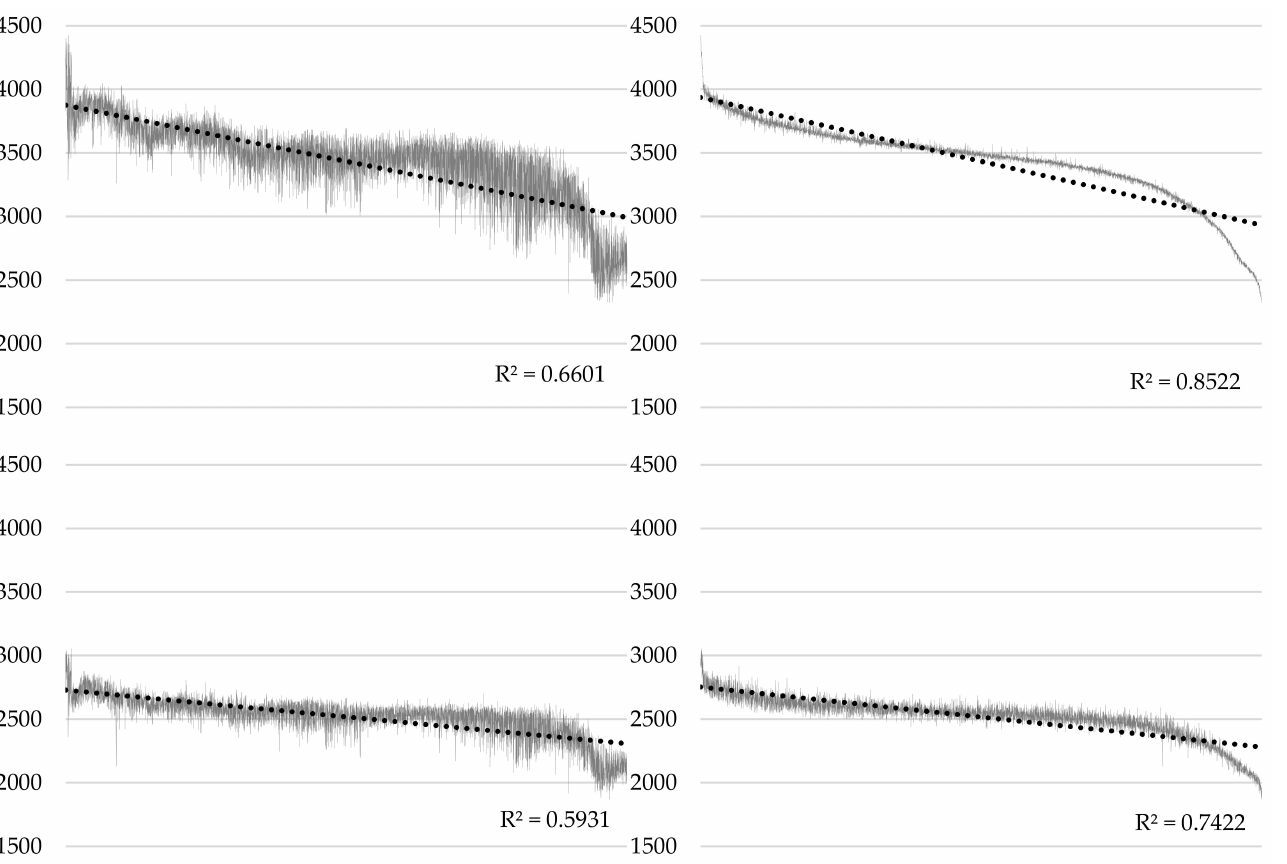
Figure 3. PV ( up ) and ST ( down ) production ordered by latitude ( left ) and solar radiation ( right ). However, even the option that best fits (upper right corner: PV depending on solar radiation) does not explain the cases where radiation is very high (Canary Islands and southern mainland) or very low (Cantabrian Sea area), where the deviation is greater than 50%. As discussed below, there is research that links the production of solar renewable energy systems (PV and ST) to the solar radiation, but this is not enough to explain the whole territory of Spain. Therefore, having performed the energy simulation and linking the results through a geographic information system is relevant. As will be observed in the maps, geographical latitude substantially conditions the performance obtained, although local climatic conditions (altitude, cloud cover, prevailing winds, etc.) will weigh these